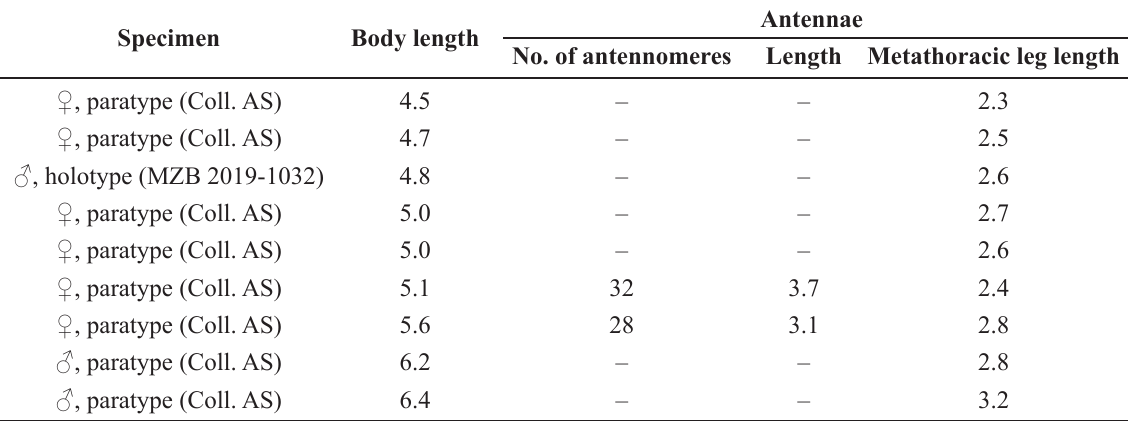
Table 2. Plusiocampa ( Plusiocampa ) apollo Sendra, Giachino & Vailati sp. nov. Length of the body, antennae and metathoracic legs (measurements in mm), in addition to the number of antennomeres. Specimen Body